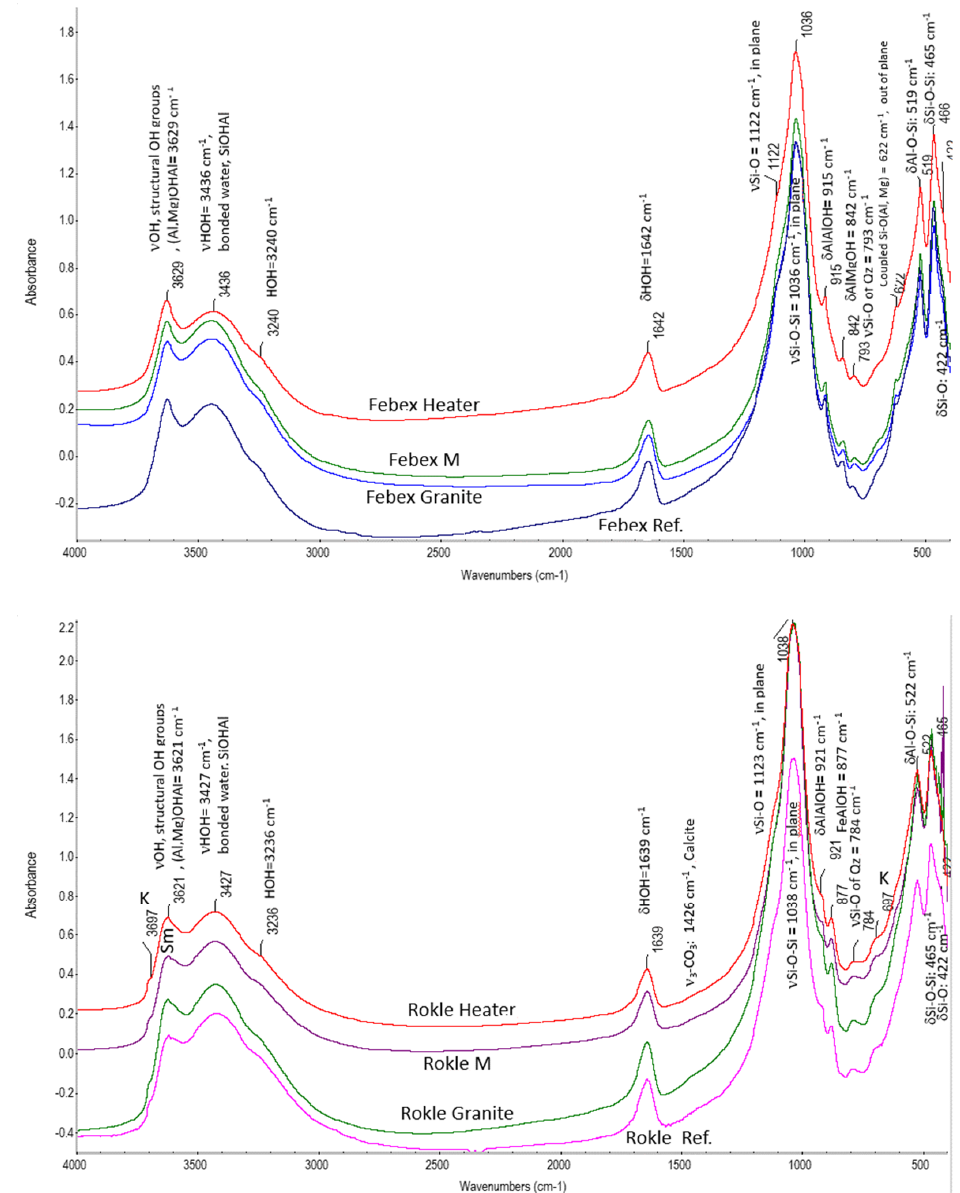
Figure 7. FTIR spectra from samples taken from the ABM5 experiment: Asha 505 block 28 Febex block 25 and Rokle Block 14.